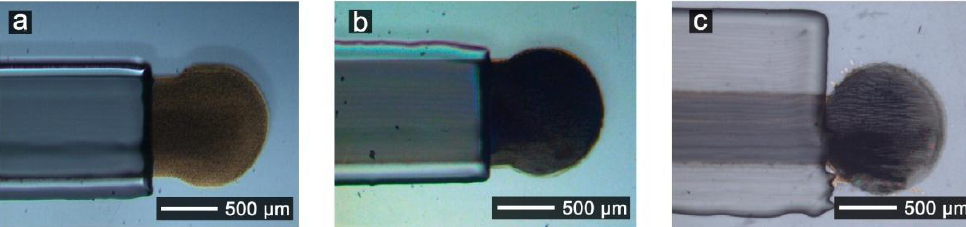
Figure 2. Optical microscopy images of printed electrodes: ( a ) 1-layer Au, ( b ) 12-layer SWCNT (7.5 mg/mL of SWCNT), and ( c ) 12-layer SWCNT-SNP-HRP (5 mg/mL of SWCNT and 5 mg/mL of SNP-HRP).